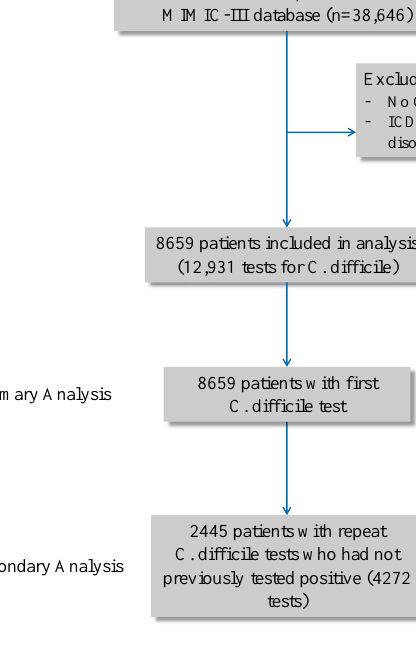
Figure 1. Study flow. Table 1. Baseline characteristics of patients in the intensive care unit with diarrhea with and without Clostridioides difficile infection on initial testing.